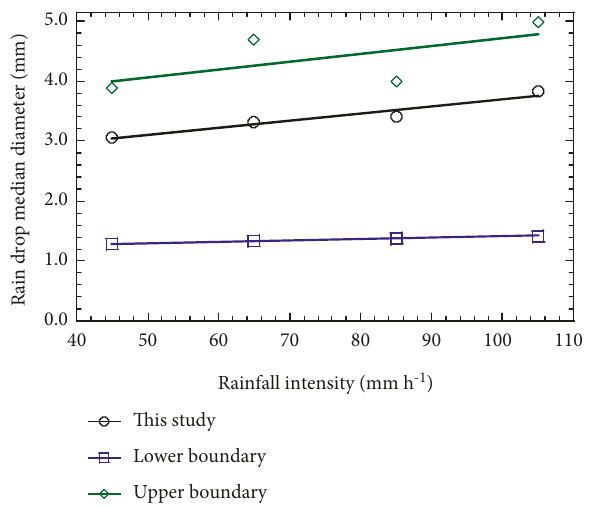
Figure 6: Changes in median diameter with rainfall